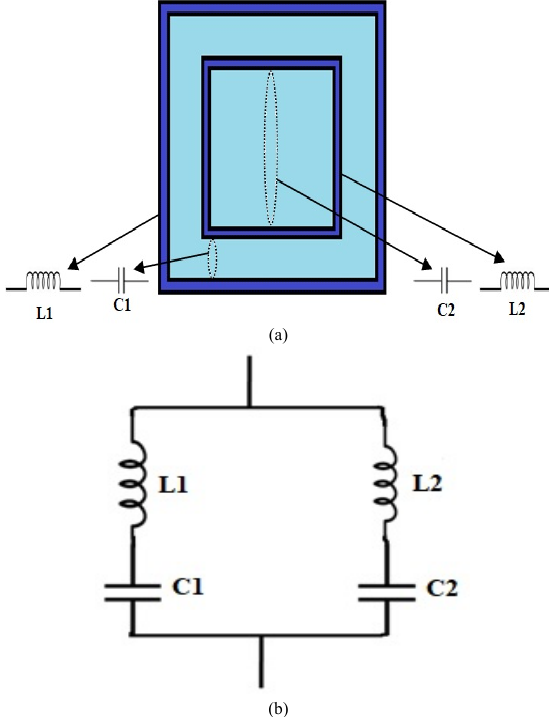
(b) FIGURE 3: .DSLFSS lumped circuit elements and equivalent circuit (a) DSLFSS with lumped circuit elements, and (b) Equivalent Circuit of single unit cell